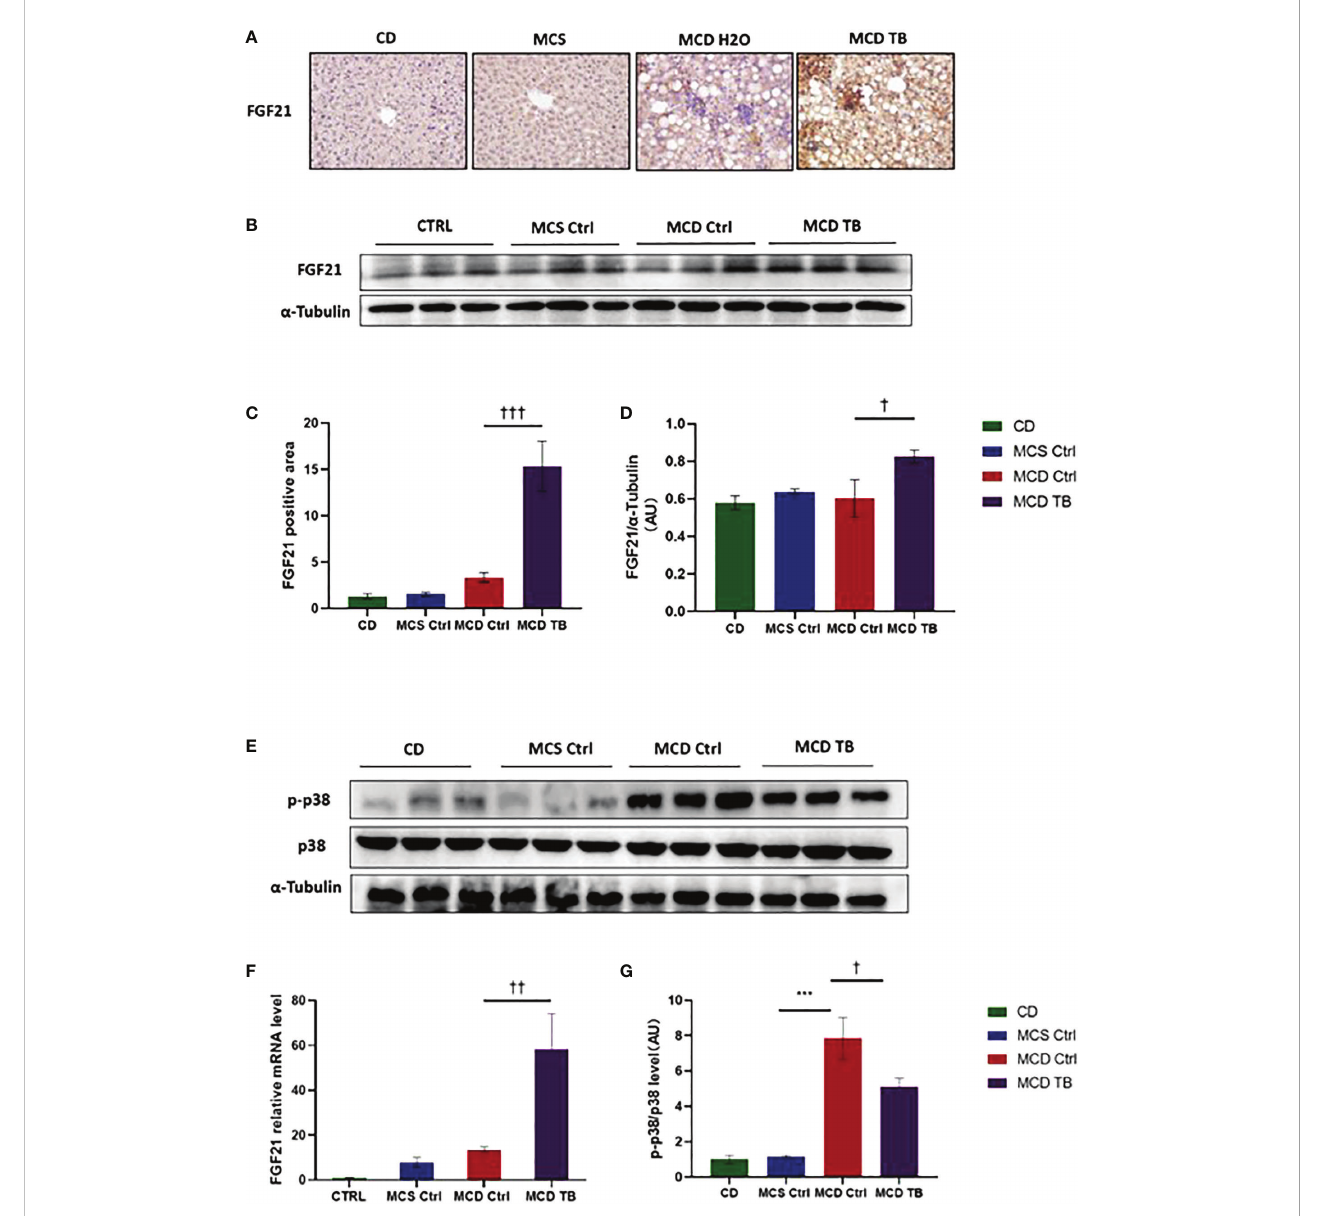
FIGURE 7 Theabrownin increases the expression of FGF21 and reduces the phosphorylation of MAPK p38 in MCD diet-fed mice. (A) IHC for FGF21. (B) FGF 21 protein levels from western blot. (C) Quanti fi cation of IHC positive area for FGF21. (D) Quanti fi cation of FGF 21 protein levels from western blot. (E) p38 protein level and p38 phosphorylation. (F) FGF21 mRNA level. (G) Quanti fi cation of p38 phosphorylation (normalized by total p38). AU, arbitrary units. n=5-11 mice per group. The data are mean ± s.e. (error bars). ***p < 0.001, MCS Ctrl vs. MCD Ctrl. † , p<0.05, †† , p<0.01, ††† , p<0.001 MCD Ctrl vs. MCD